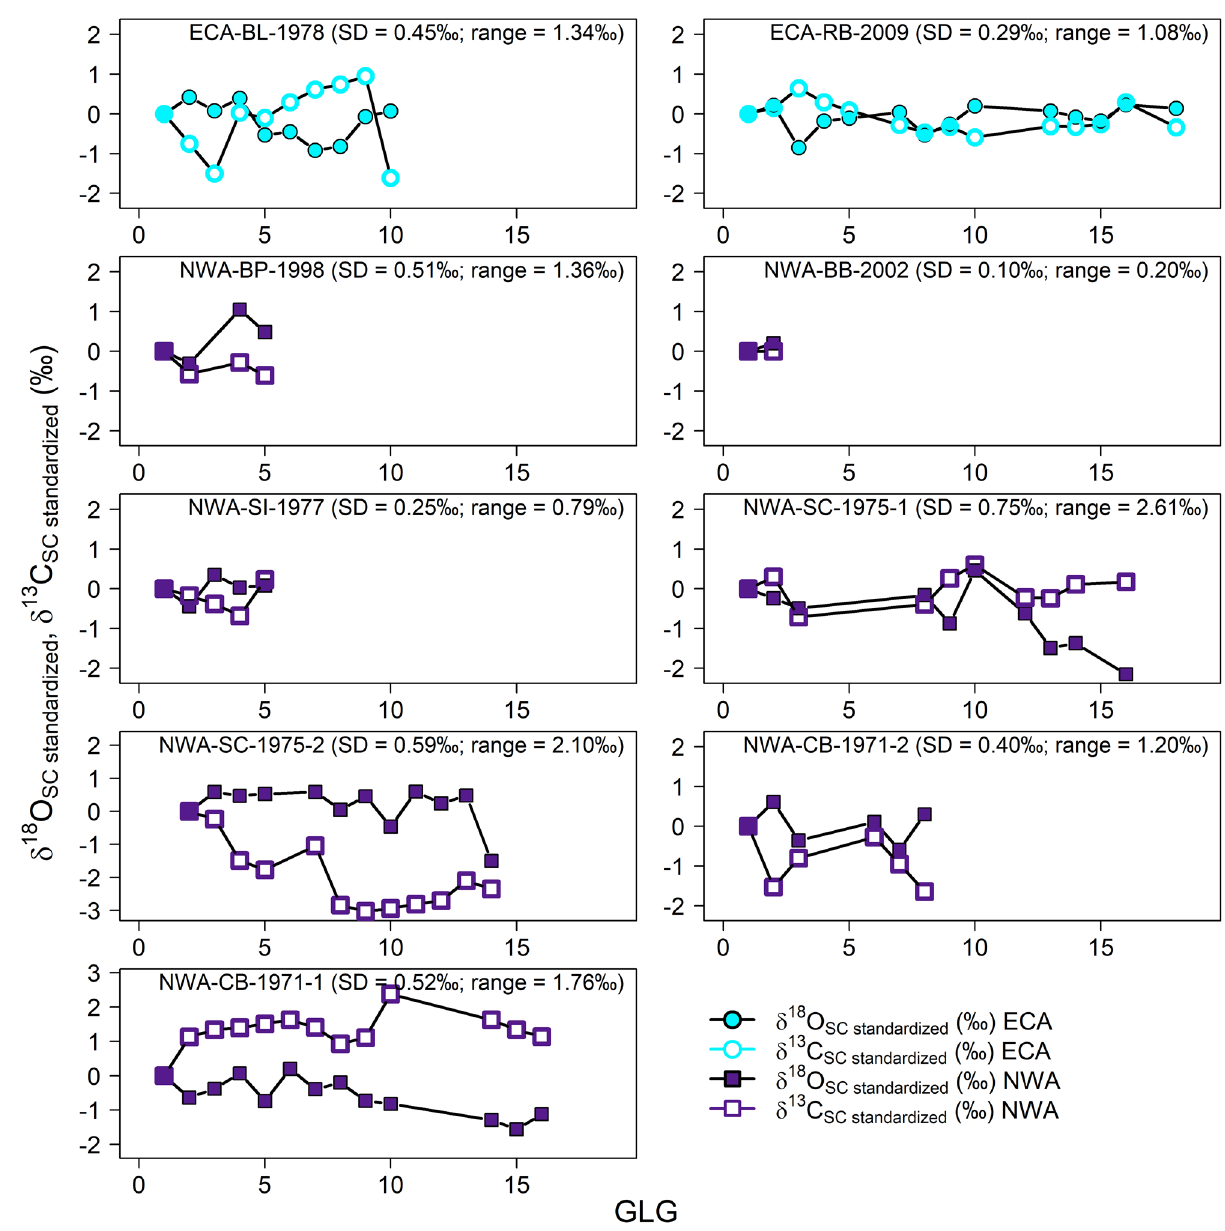
Figure 5. δ 18 O SC (solid) and Suess-adjusted δ 13 C SC (open) of individual annual dentine growth layer groups (GLGs) of teeth from killer whales that stranded in the eastern Canadian Arctic (ECA; turquoise circles) and the Northwest Atlantic (NWA; purple squares). Values are standardized to that of the first GLG. Higher within- tooth δ 18 O SC variation indicates greater interannual variability in distribution. Although dietary influences on δ 13 C SC cannot be constrained, concurrent (often inverse) variation in δ 13 C SC with δ 18 O SC in most of the profiles is consistent with patterns exhibited in the North Atlantic δ 18 O and δ 13 C isoscapes 19 . Note different axes of two lower left